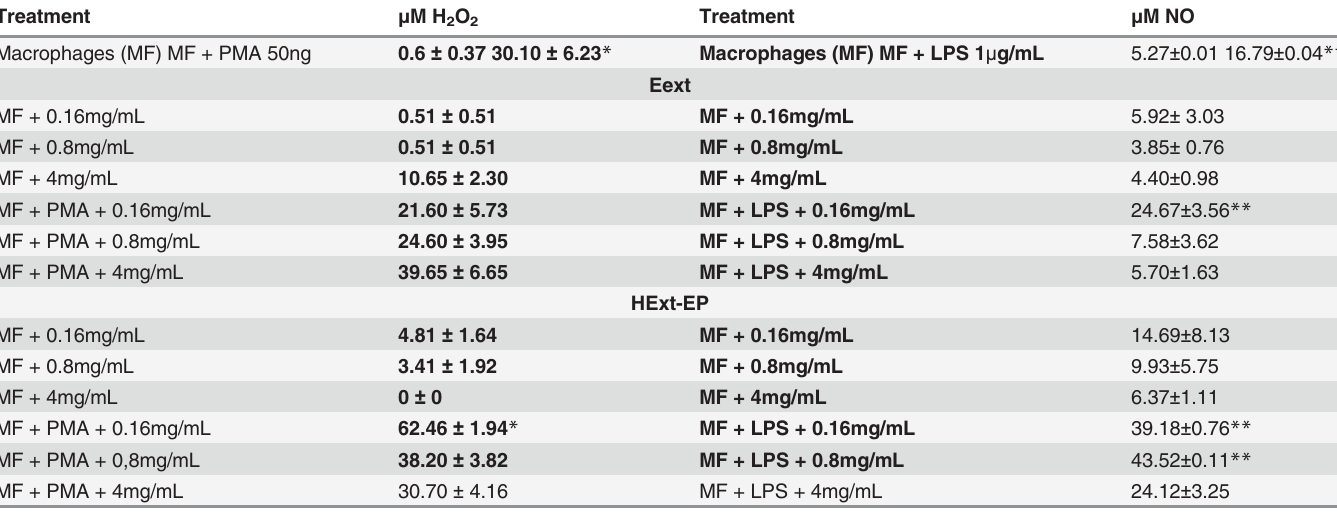
Table 2. Effect of the EExt and HExt-EP extracts on hydrogen peroxide (H 2 O 2 ) production and nitric oxide (NO) production by mouse peritoneal macrophages.